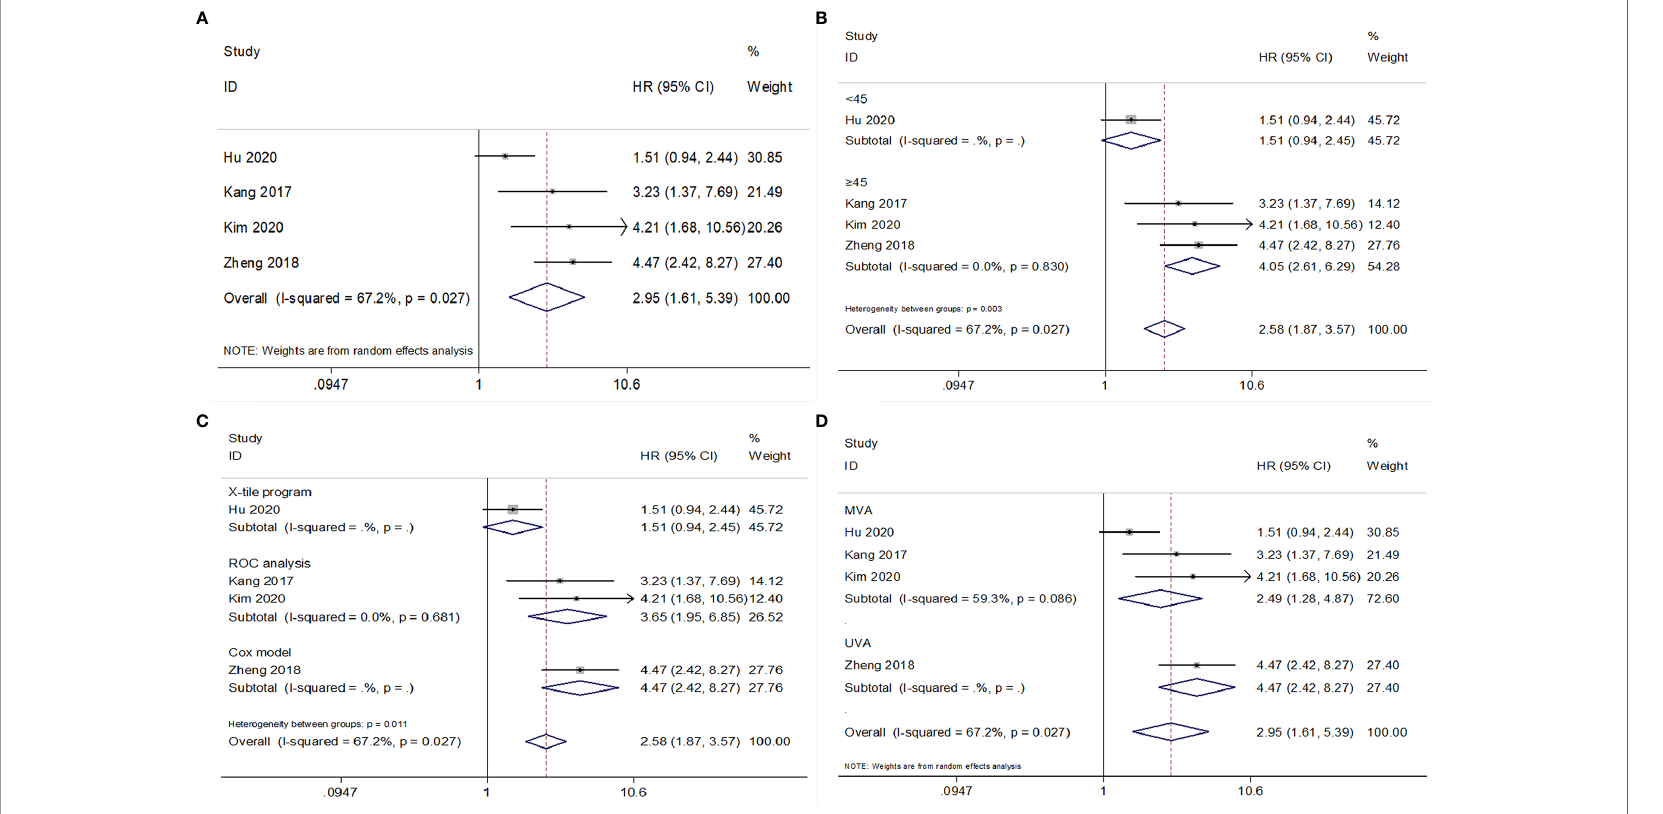
FIGURE 4 | Forest plot examining the association between PNI and CSS in patients with RCC. (A) overall patient population; (B) subgroup analysis by various cut-off values of PNI; (C) subgroup analysis by various cut-off value determination methods; (D) subgroup analysis by various survival analysis